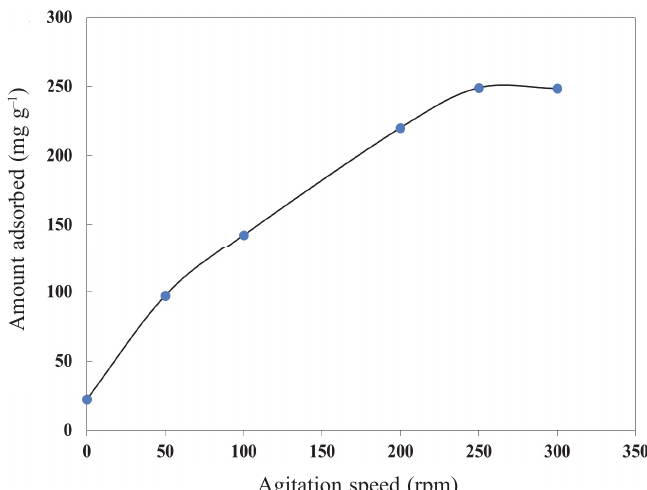
Fig. 7- Fig. 7 – Effect of agitation speed on removal of Cr(VI) by IL-rGO (sorbent dosage = 0.5 g L –1 , [Cr(VI)] = 250 mg L –1 , contact time = 5 h, temperature = 298 K and pH 4.0)